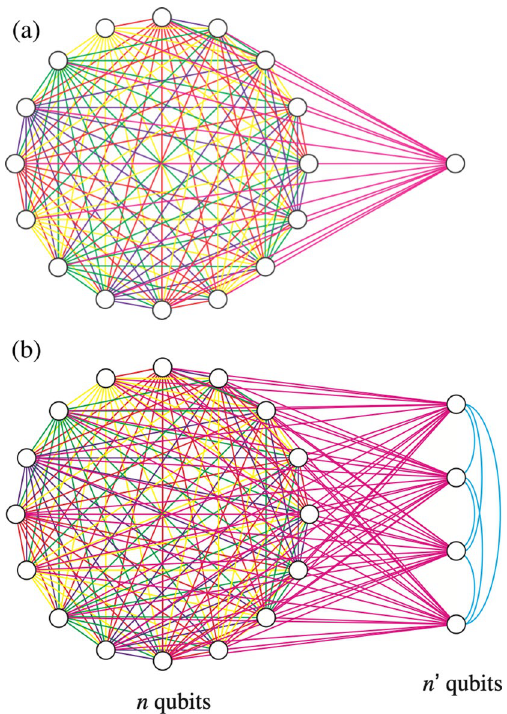
Figure 1. ( a ) Adding a qubit to the n = 16 graph. ( b ) Adding a register of n ′ ancilla qubits creates a hybrid form of SES and gate-based computation, where fast SES operations are performed on the data, traditional logic gates and measurements are performed on the ancillas, and controlled-unitaries operate